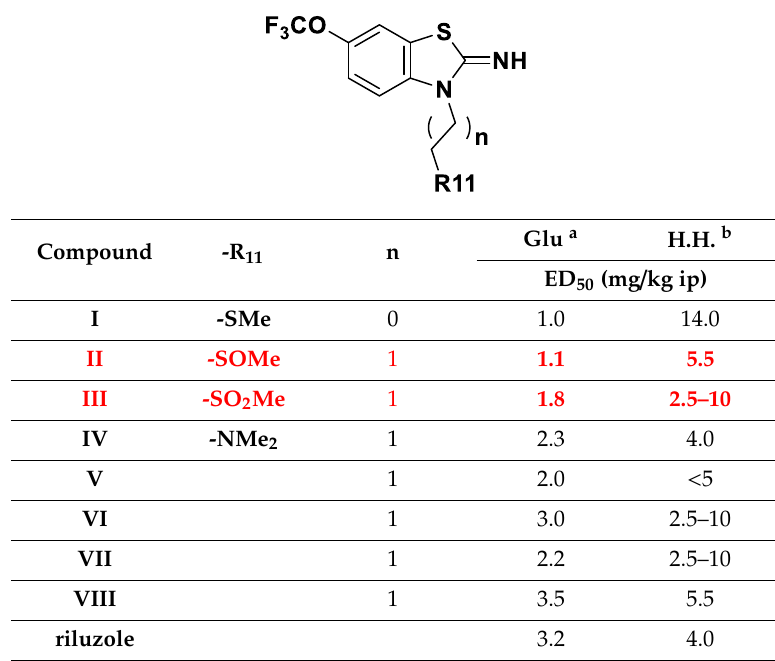
Table 3. Neuroprotective activities of benzothiazolines.